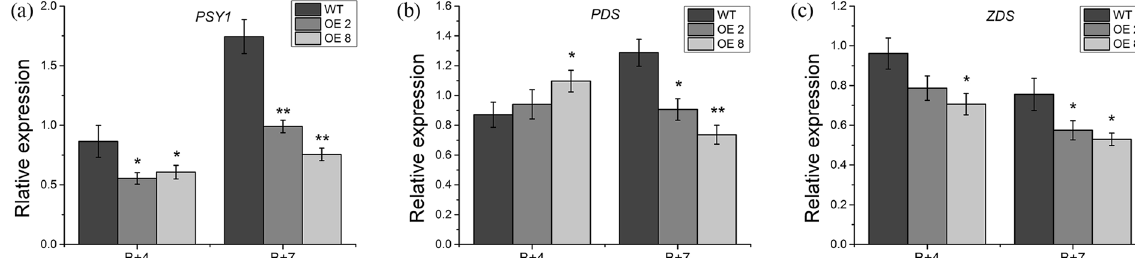
Figure 8. Carotenoid biosynthesis genes expression in fruits from 35 S:PRE2 lines and wild type. ( a ) to ( c ) respectively represent expression levels of PSY1 , PDS , and ZDS in different stage fruits of wild type and 35 S:PRE2 lines. B + 4, 4 days after breaker stage; B + 7, 7 days after breaker stage. Data are the mean ± SD of three biological replicates. * Significantly different from the wild type, P < 0.05; ** for P <